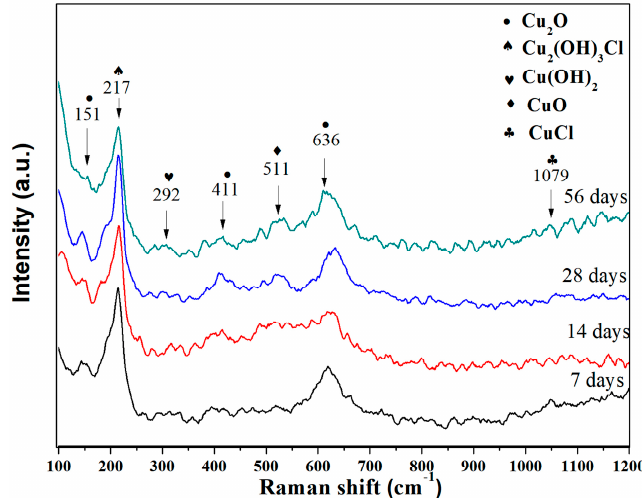
Figure 3. Raman spectrum of the corrosion product film formed on the surface of the 90 / 10 Cu-Ni alloy exposed in seawater for 28 days.